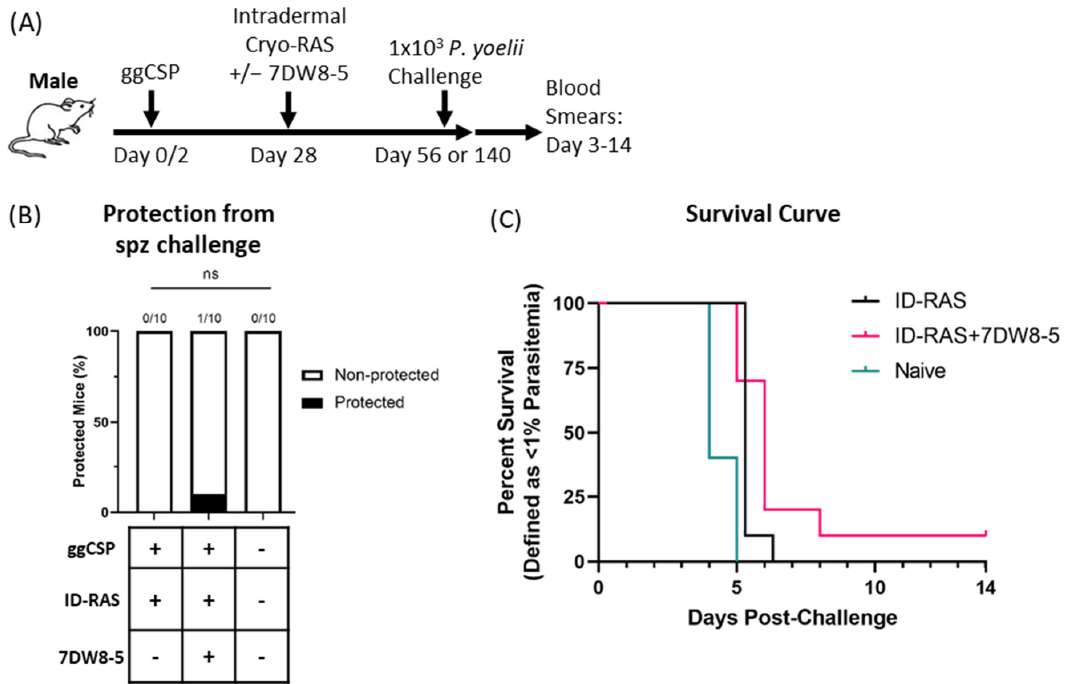
Figure 3. Prime-and-trap vaccination is not protective in male BALB/cJ mice. ( A ) Experimental de- sign of prime-and-trap protection studies. ( B ) Results of protection studies after challenge with 1 × 10 3 WT purified Py spz administered four weeks after trapping with 2 × 10 4 ID administered cryo- RAS +/ − 7DW8-5. Protection data was from N = 10 male BALB/cJ mice across two independent ex- periments and analyzed with Fisher Exact Test, ns p > 0.05. ID = two 2.5 μ L injections for all. ( C ) Survival curve of mice from ( B ). experiments and analyzed with Fisher Exact Test, ns p > 0.05. ID = two 2.5 µ L injections for all. ( C ) Survival curve of mice from ( B